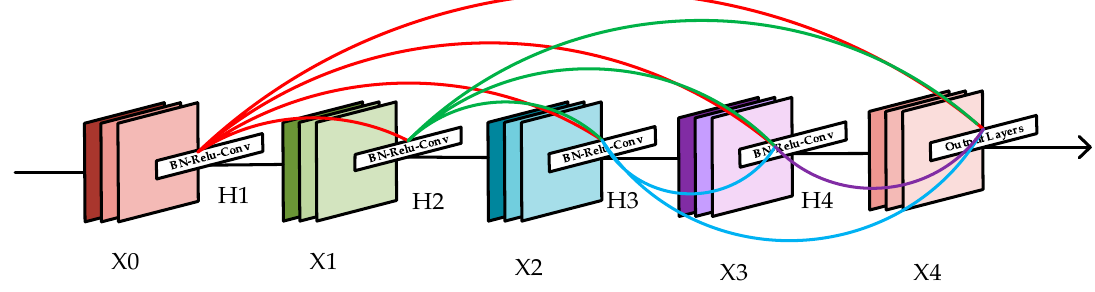
Figure 4. The structure of DenseNet.